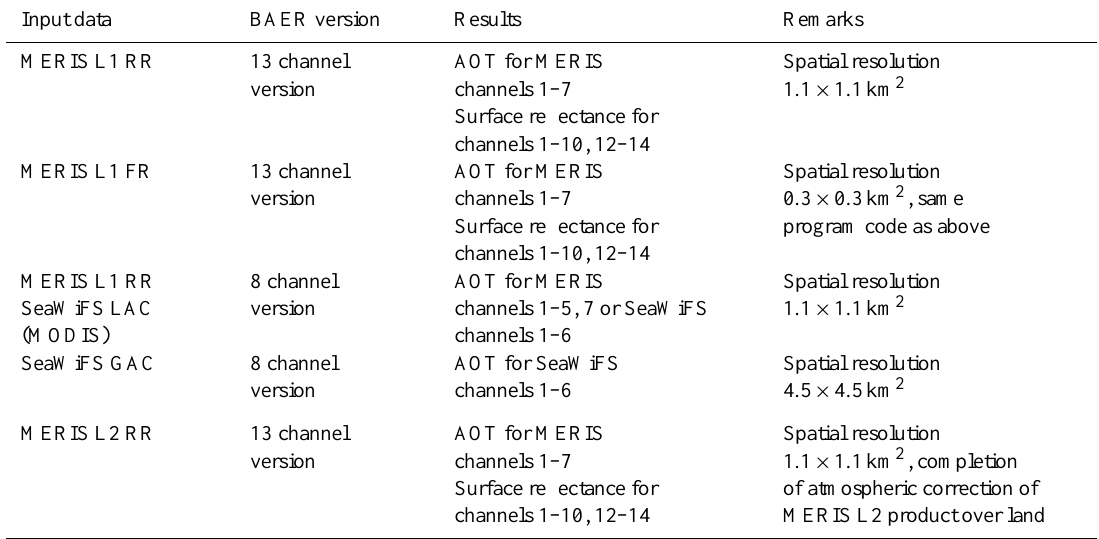
Table 4. Overview of BAER versions.